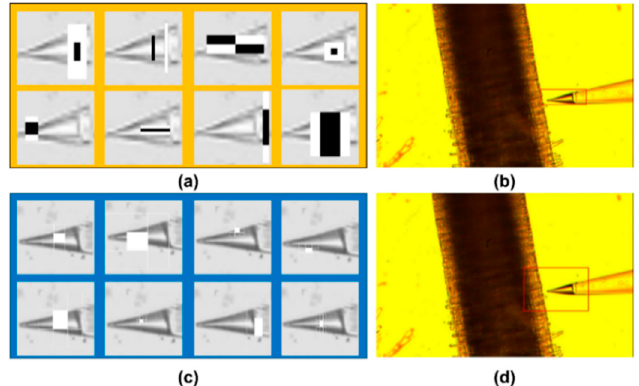
Figure 12. Extracting the region of interest (ROI). Note: ( a ) is the visualization of some Haar-like features of ISME tip; ( b ) is the recognition result of the ISME tip; ( c ) is the visualization of some local binary pattern (LBP) features of the ISME tip; and ( d ) is the result of ROI extraction.